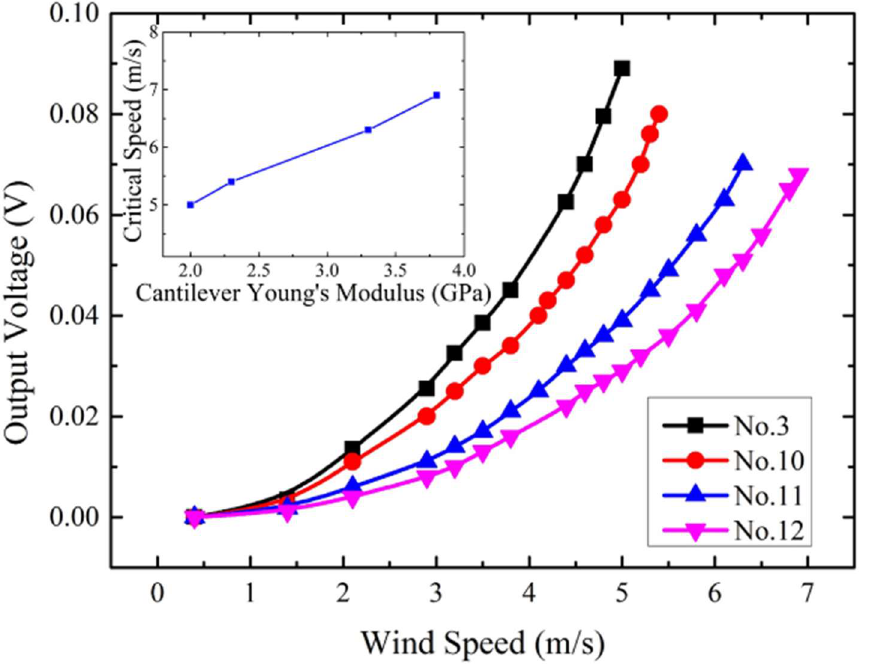
Figure 6. Experimental output voltage versus wind speed characteristics for prototypes with different substrate Young’s modulus.